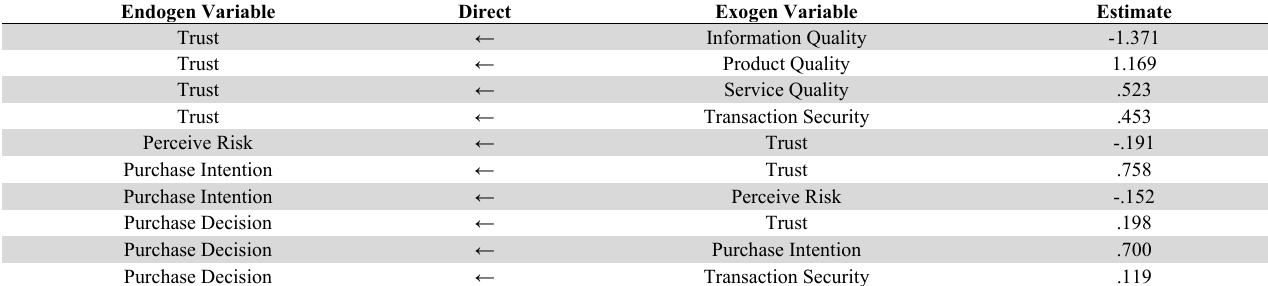
Regression Weight Structural Equational